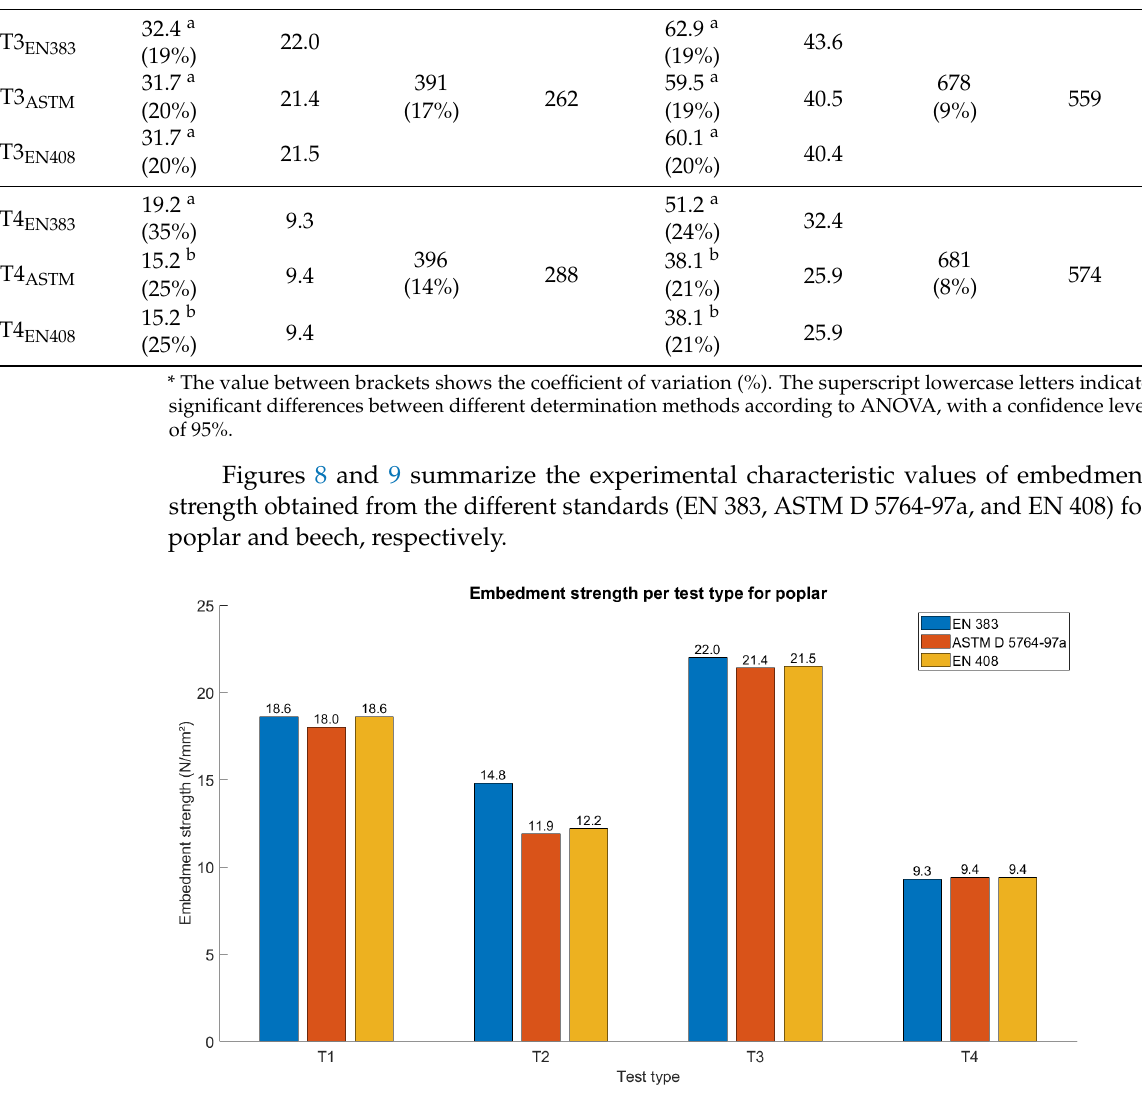
Figure 8. Experimental values according to the different studied methods per test type for poplar.